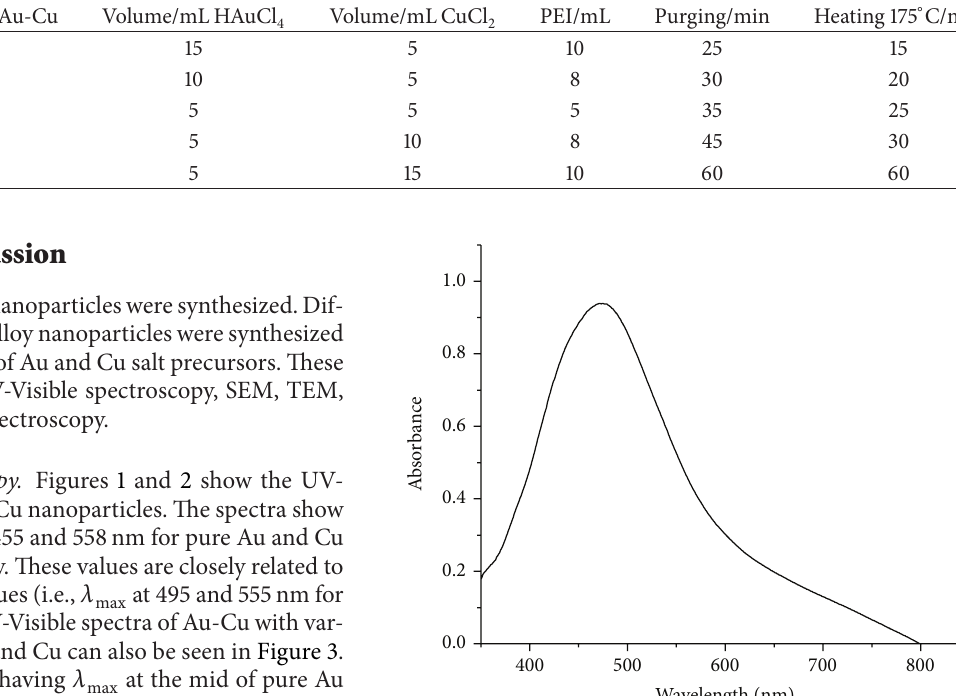
Table 2: Chemicals and conditions required for preparation of various compositions of Au-Cu alloy nanoparticles. S. number